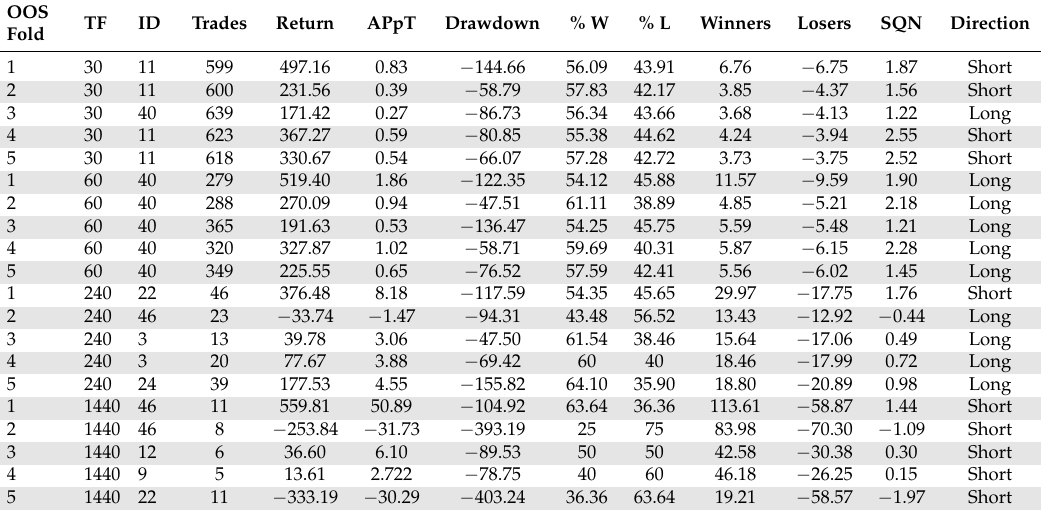
Table 5. Results are better for those strategies with more trades. Each out of sample period runs for a period of over two